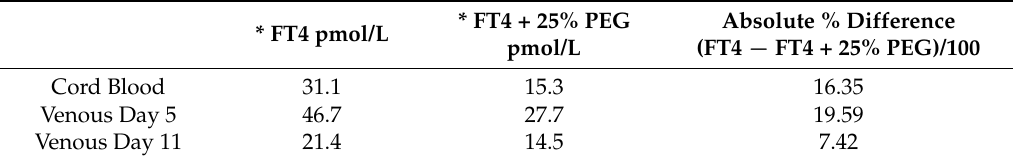
Table 2. Data showing absolute % difference between FT4 values pre and post 25% PEG treatment. * FT4